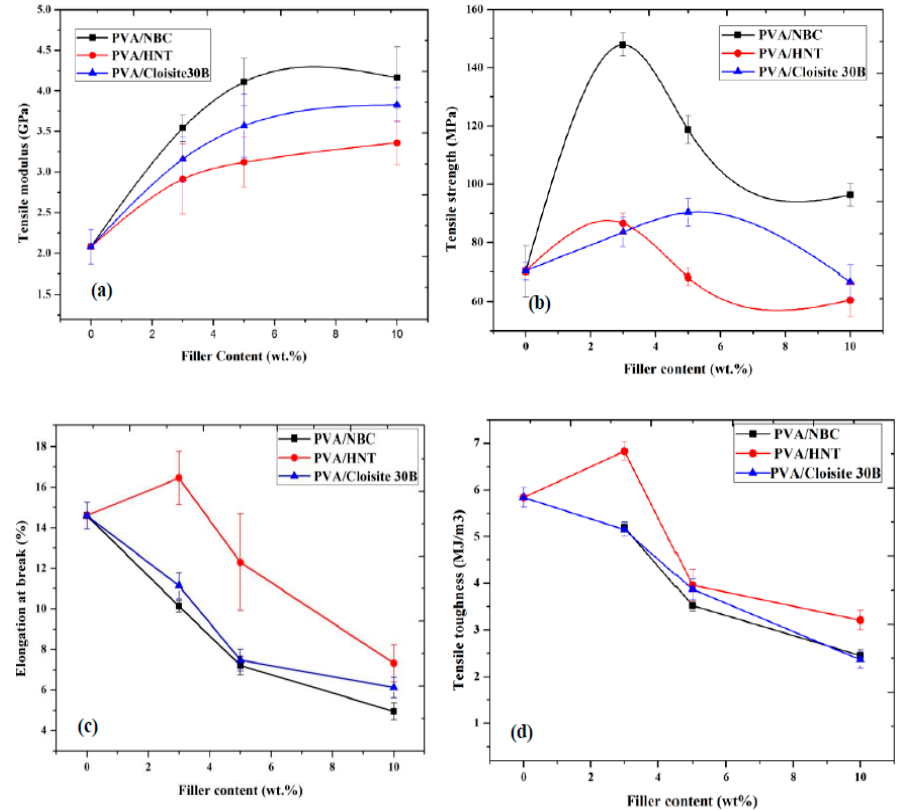
Figure 7. Mechanical properties of PVA bionanocomposites at different filler contents: ( a ) tensile modulus. ( b ) tensile strength, ( c ) elongation at break, and ( d ) tensile toughness.